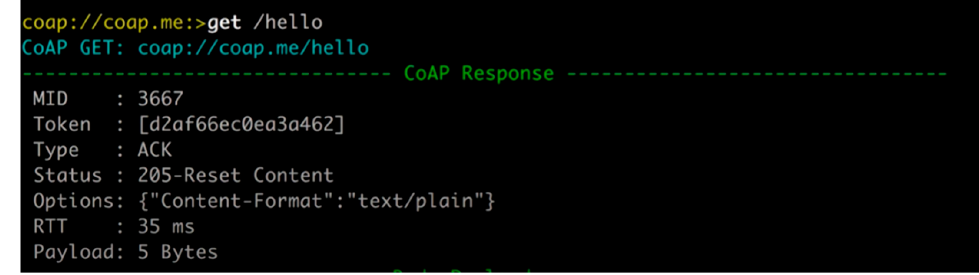
Figure 22. CoAP response to the provided GET method.